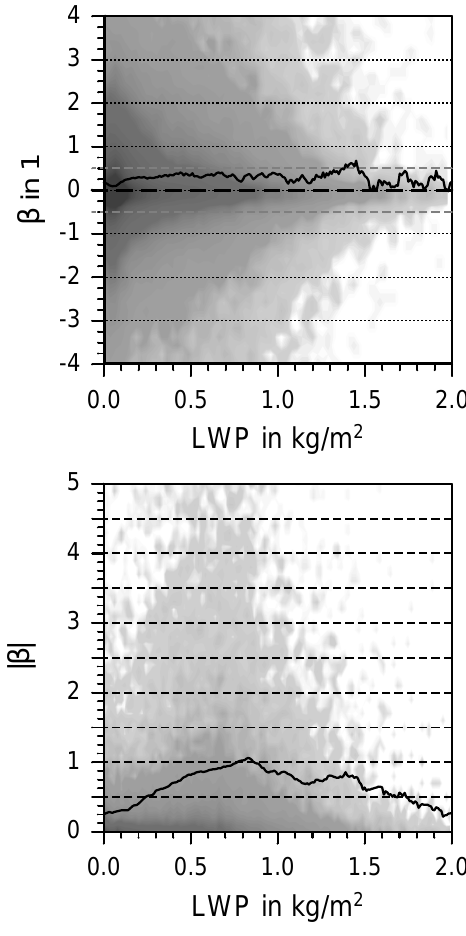
Fig. 11. (a) Simulated precipitation susceptibility β as a function of cloud liquid water path LWP for all grid points for 19–20 Au- gust 2005 and (b) | β | for all grid points with more than 0.2mm per hour for the same period. Shadings show the joint histogram for the available precipitation data. Dark colors indicate a high density of data